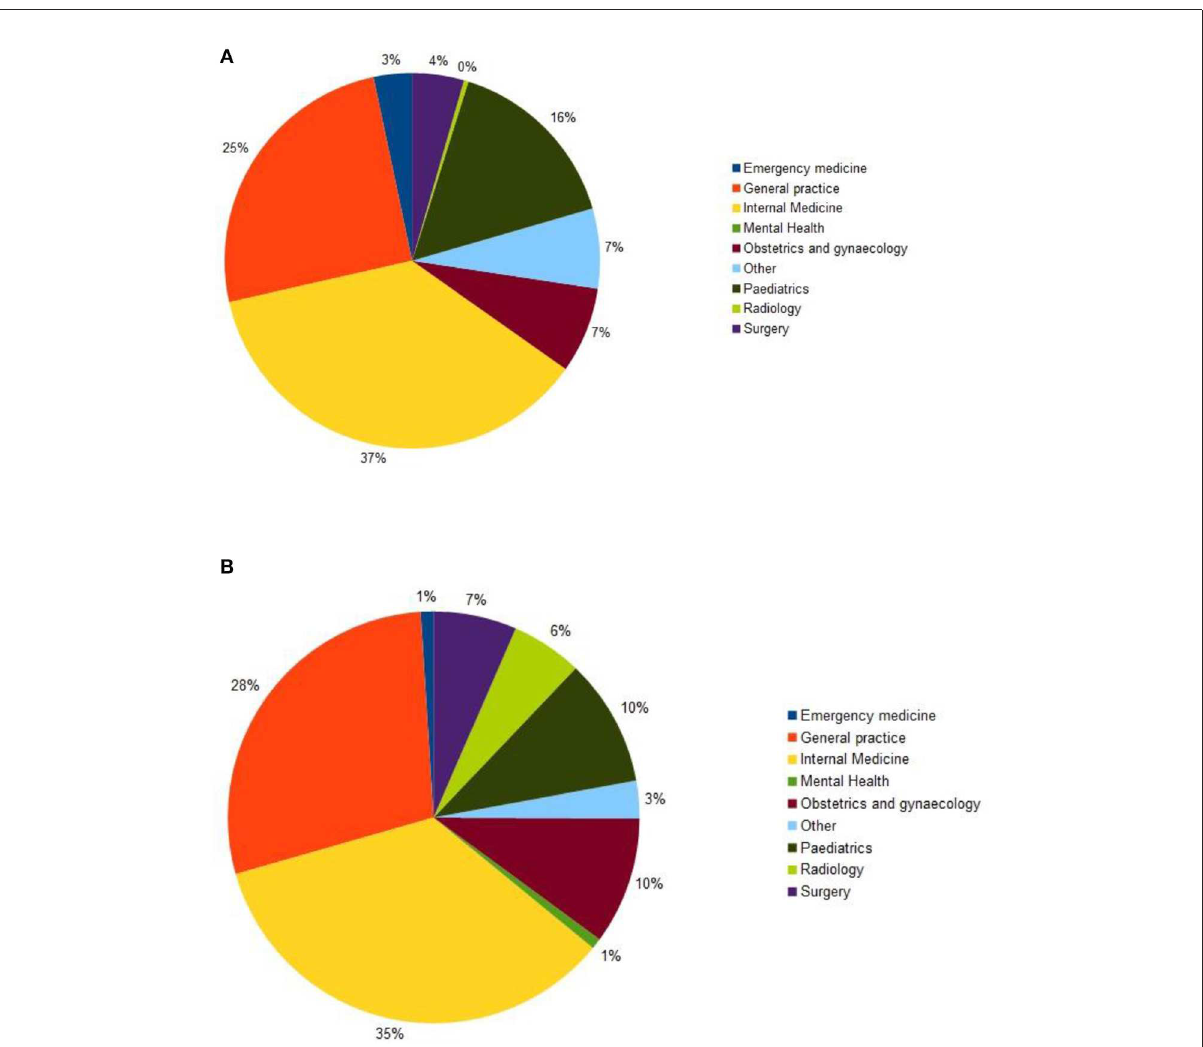
FIGURE4 Type of expertise: (A) during the baseline period ( n = 785); (B) during the pandemic period ( n = 2,990).